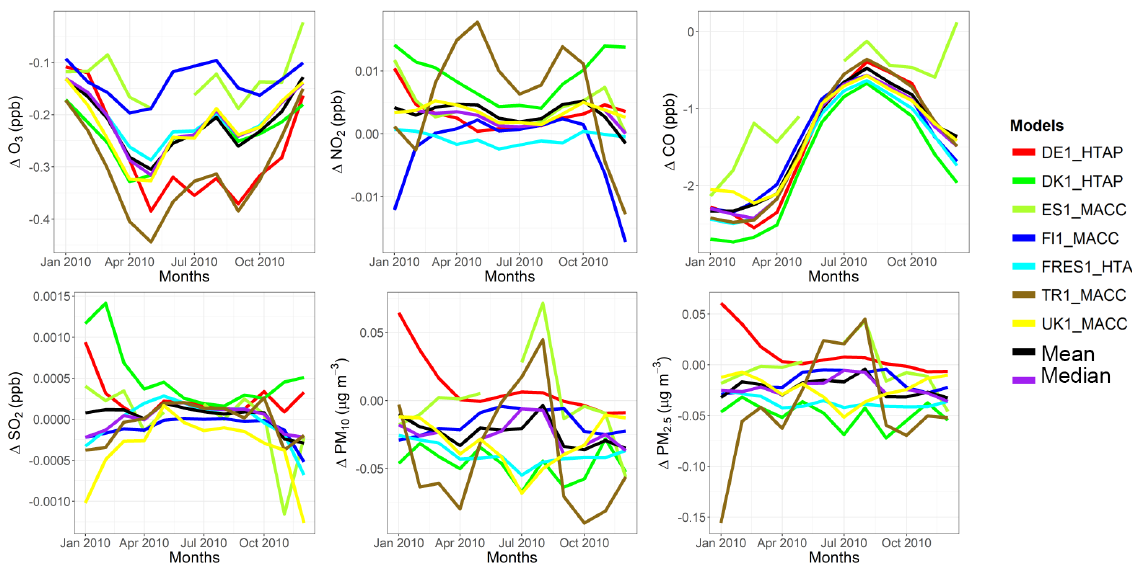
Figure 9. Absolute impact of the 20% reduction of the North American anthropogenic emissions over Europe (NAM EUR − BASE EUR ).